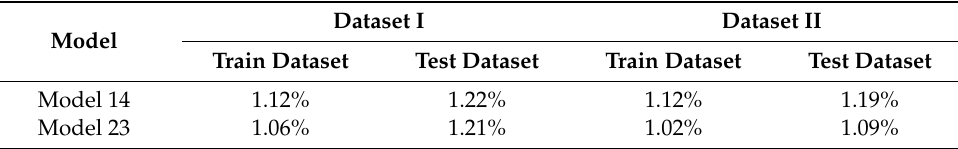
Table 8. The average RMSE for normal aging trajectory prediction by Model 14 and Model 23.